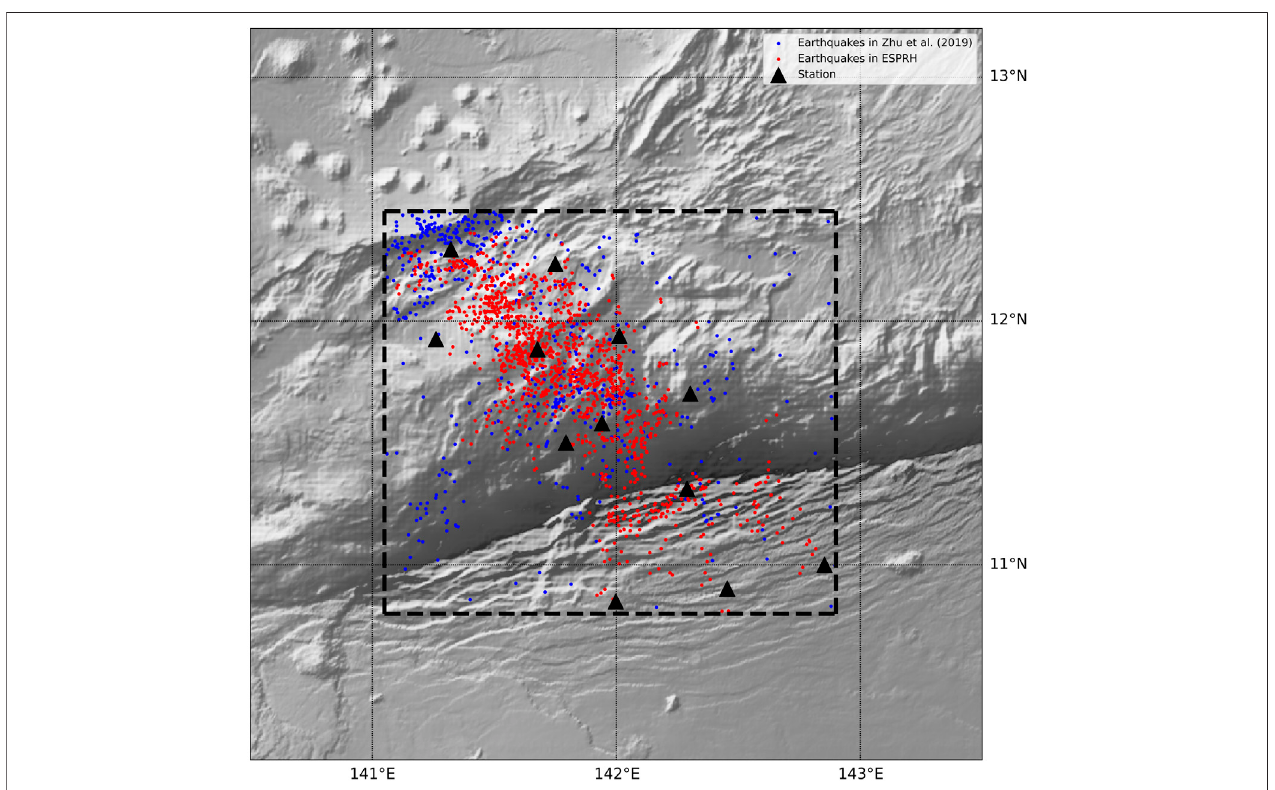
FIGURE 5 | Comparison of location result of ESPRH (blue dots) and Matched fi ltering (red dots) by Zhu et al. (2019) SWMR, Southwest Mariana rift.